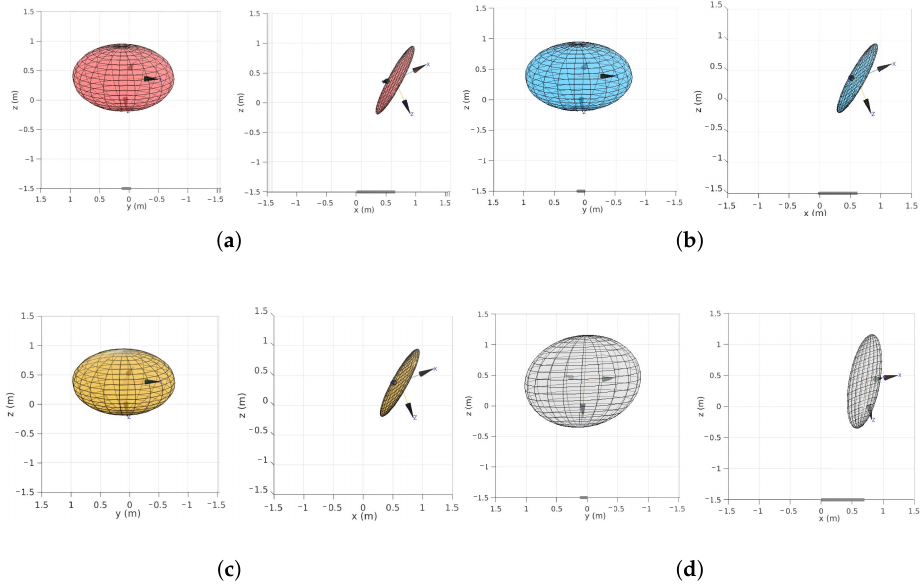
Figure 9. Manipulability ellipsoid in its minimum amount for three translation degrees of freedom in different VS approaches. ( a ) The manipulability ellipsoid of the robot in its minimum value with the PBVS approach. ( b ) The manipulability ellipsoid of the robot in its minimum value with the IBVS approach. ( c ) The manipulability ellipsoid of the robot in its minimum value with the HVS approach. ( d ) The manipulability ellipsoid of the robot in its minimum value with DHVS